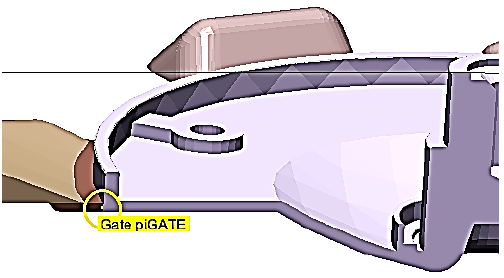
Figure 7. The location of the melt temperature evaluation in the gate.